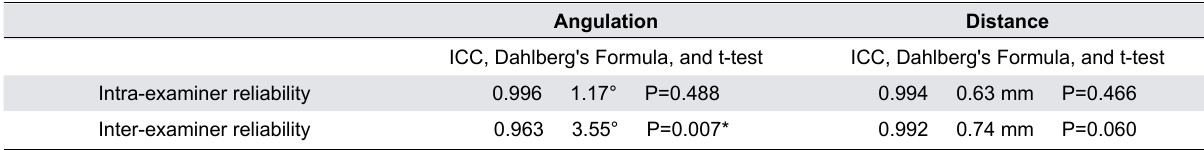
Table 2- Intra- and Inter-examiner reliability for angulation and height of PCCS (ICC, Dahlberg’s Formula, and t -test)